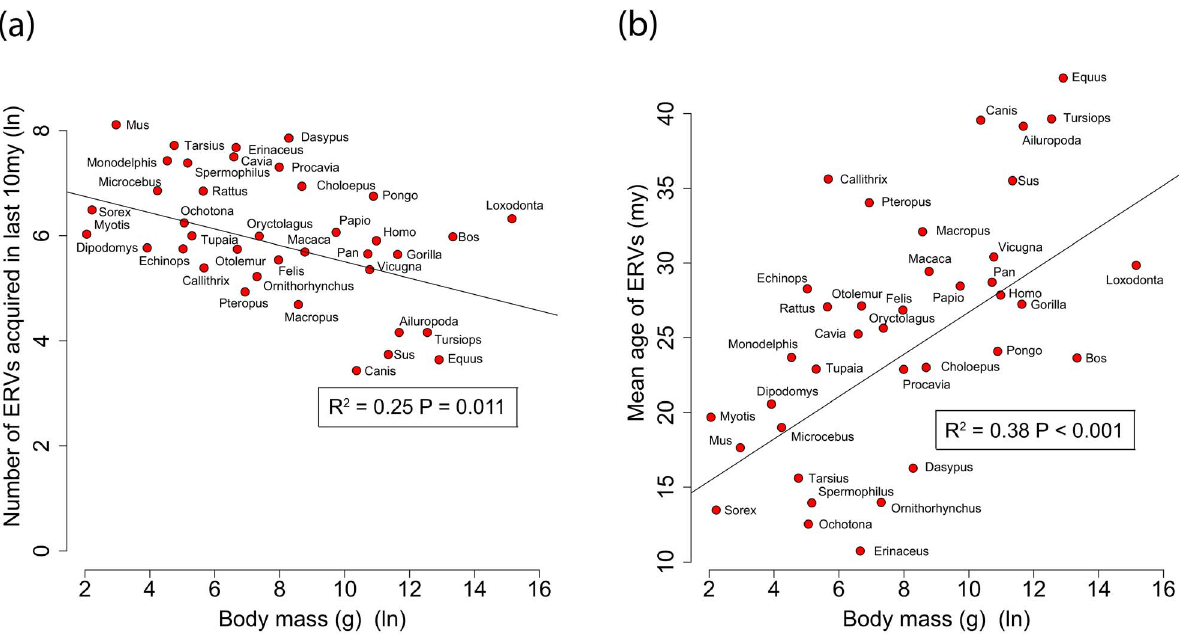
Figure 2. (a) Correlation between ERV count and body mass for the number of ERV integrations acquired over the last 10 my. (b) Correlation between mean age of all ERV integrations and body mass from the genomes of 38 mammals. Body mass is log-transformed, and the mean ages are calculated correcting for the substitution rate. We have not taken into account the effect of body size on substitution rate in calculating the ages.